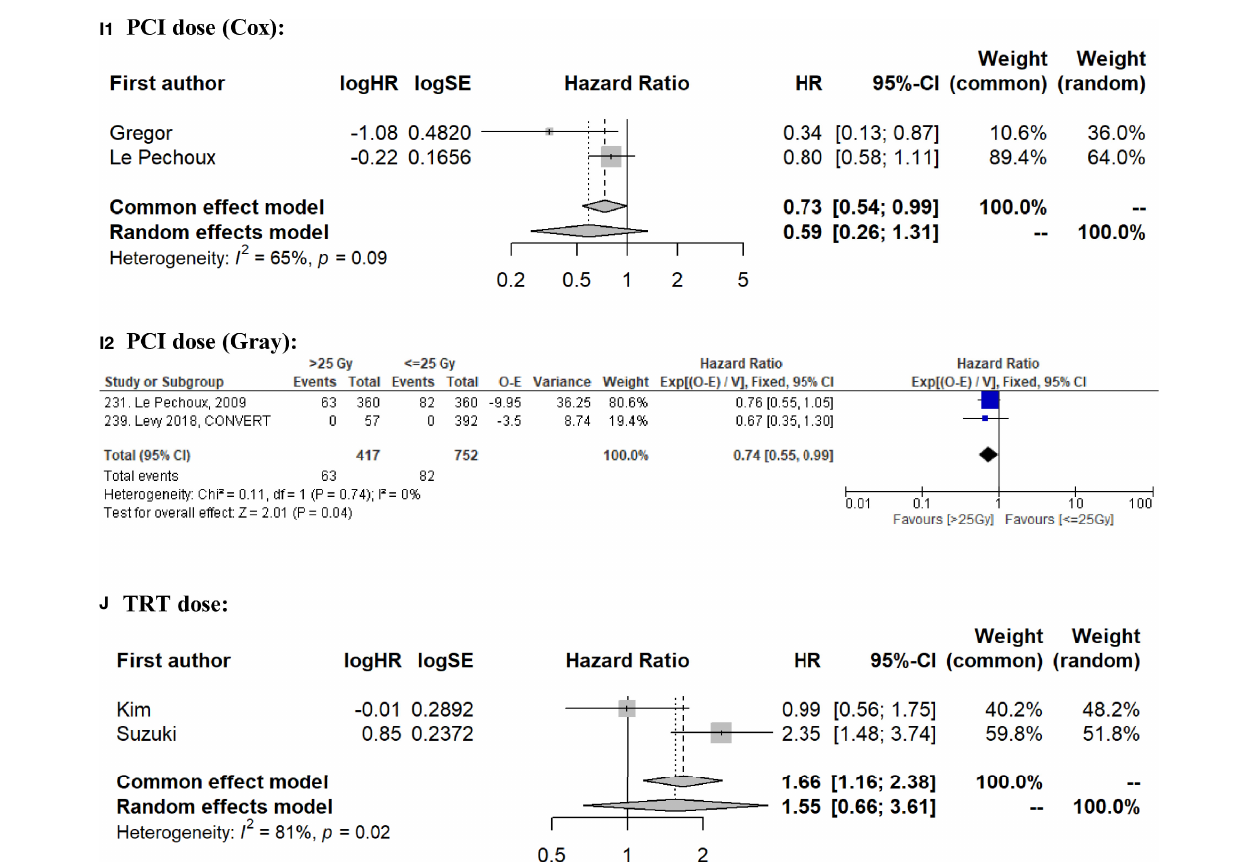
FIGURE 3 | Forrest plots for BM: (A) Age; (B) Sex; (C) Smoking; (D) T stage; (E) c-stage; (F) M status in ED-SCLC; (G) PS; (H1) PCI in SCLC; (H2) PCI in ED- SCLC; (I1) PCI dose (Cox); (I2) PCI dose (Gray); (J) TRT dose. BM, brain metastasis; LD, limited-stage disease; ED, extensive-stage disease; SCLC, small cell lung cancer; PCI, prophylactic cranial irradiation; PS, performance status; TRT, thoracic radiotherapy; O, observed events; E, expected events; V, variance; CI, con fi dence interval; HR, hazard ratio; SE, standard